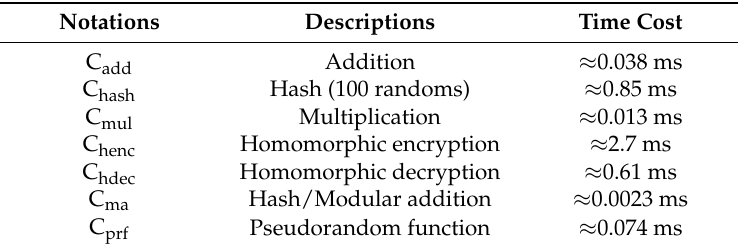
Table 2. Average time for functions.